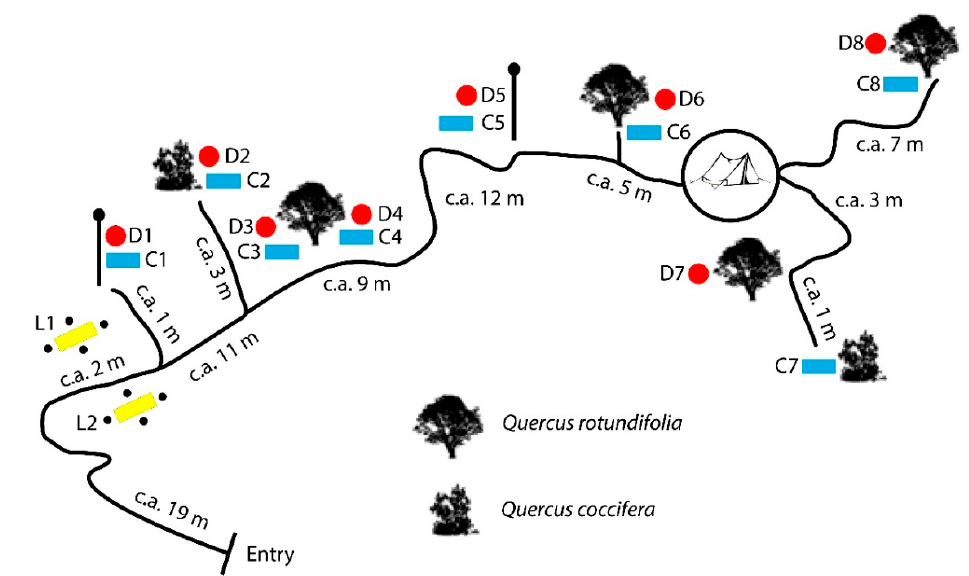
Figure 4. The location of the traps in the research field. Black lines represent the path connecting traps; solid red circles represent McPhail traps ( D ); solid blue rectangles represent pitfall traps ( C ); solid yellow rectangles represent carrion on surface ( L ) traps; small solid black circles represent jars.